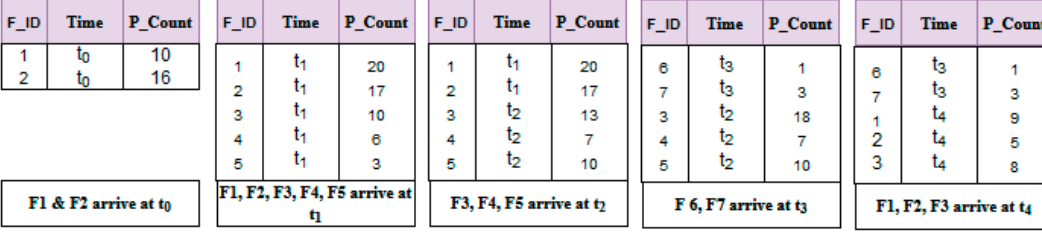
Figure 2. Example of ine ffi cient flows eviction Figure 2 Example of inefficient flows eviction scheme